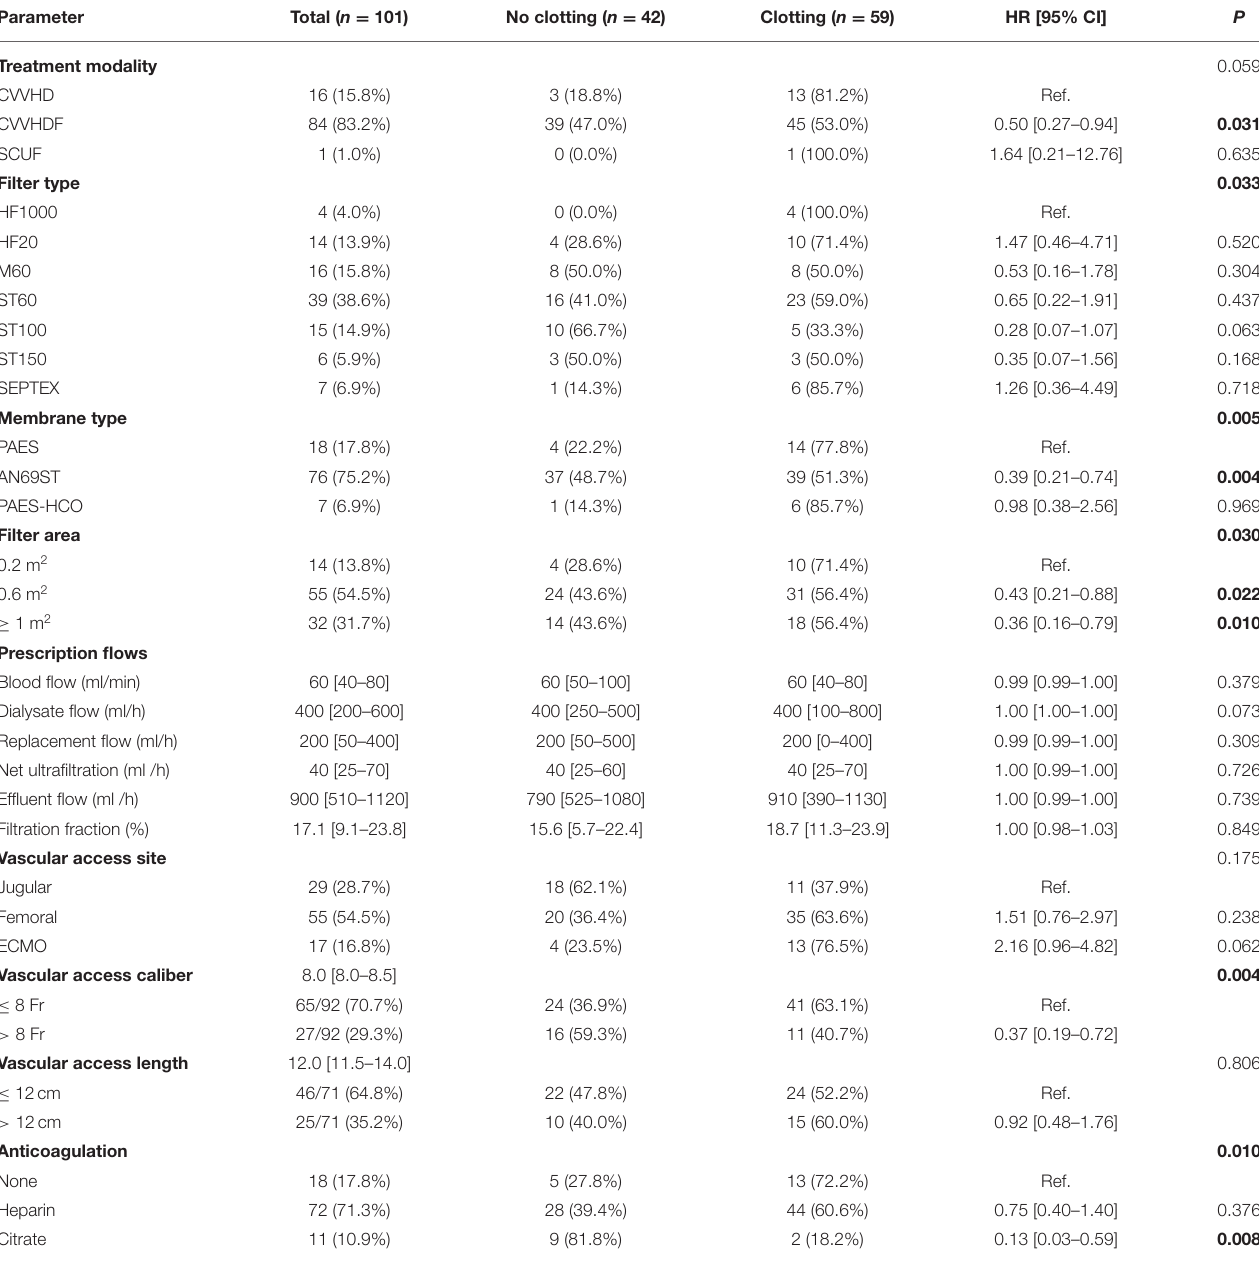
TABLE 3 | Prescription characteristics and clotting predictors of continuous renal replacement therapy sessions.